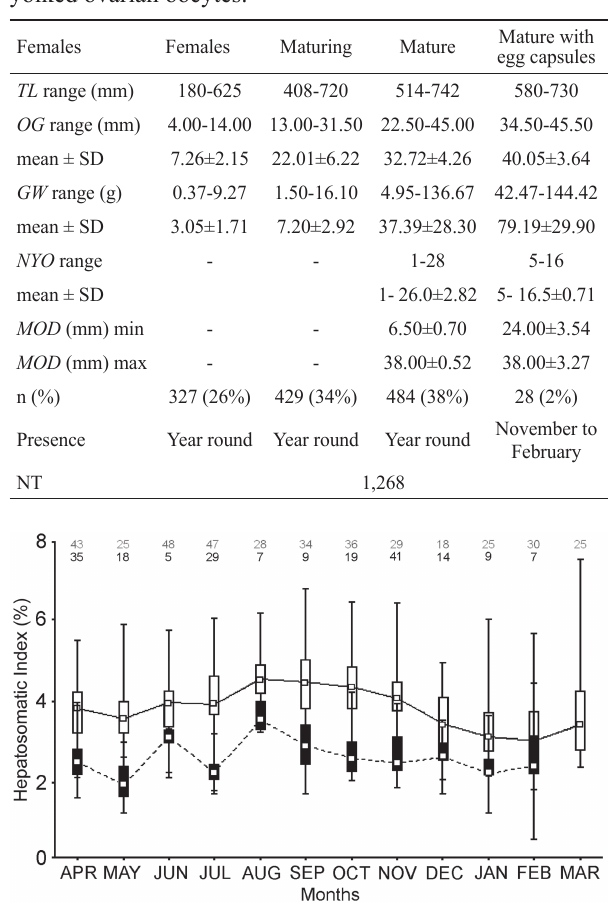
Fig. 6. Monthly variation of the hepatosomatic index (HSI) of Sympterygia bonapartii from San Matías Gulf (Argentina). Mature males (■) and mature females (□). Boxes indicate the percentiles 25- 75%; the inner square indicates the median value and bars the range of data distribution. The number of individuals analysed is given in dark grey for females and black for males.